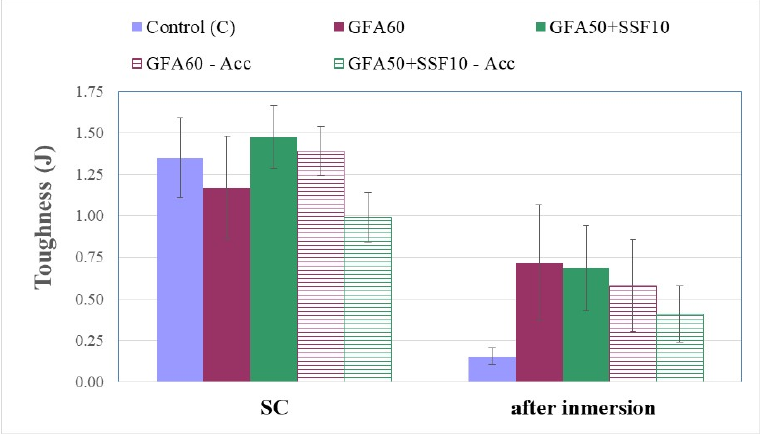
Figure 15. Toughness of the GRC composites before (SC series) and after immersion (28 days) in a 0.5 M H 2 SO 4 solution.